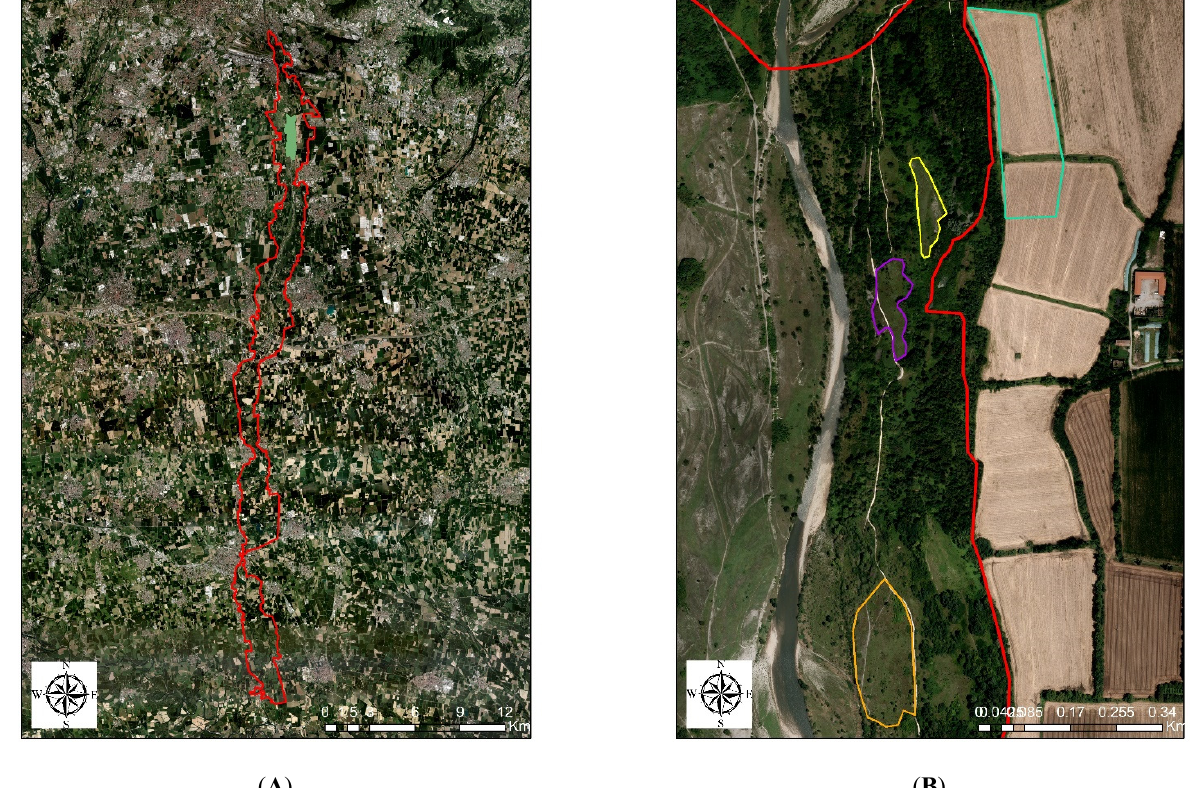
Figure 1. Map of the studied area: ( A ) Parco del Serio border (red line) and Malpaga-Basella Nature Reserve (green area); ( B ) Surveying stations in the Malpaga-Basella Nature Reserve (station 1: yellow line, station 2: purple line, station 3: orange line), and in the Miscanthus x giganteus crop (station 4: green line). https://www.cartografia.servizirl.it/arcgis2/services/BaseMap/Ortofoto2018/ImageServer/WMSServer (accessed on 16 October 2019).